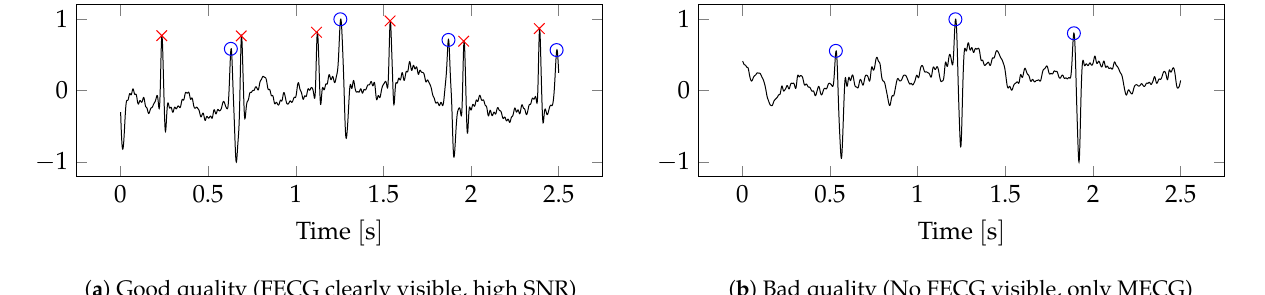
Figure 3. Examples of good- and bad-quality segments. Only the first abdominal channel is shown. Blue circle: maternal R peak, red cross: foetal R peak.